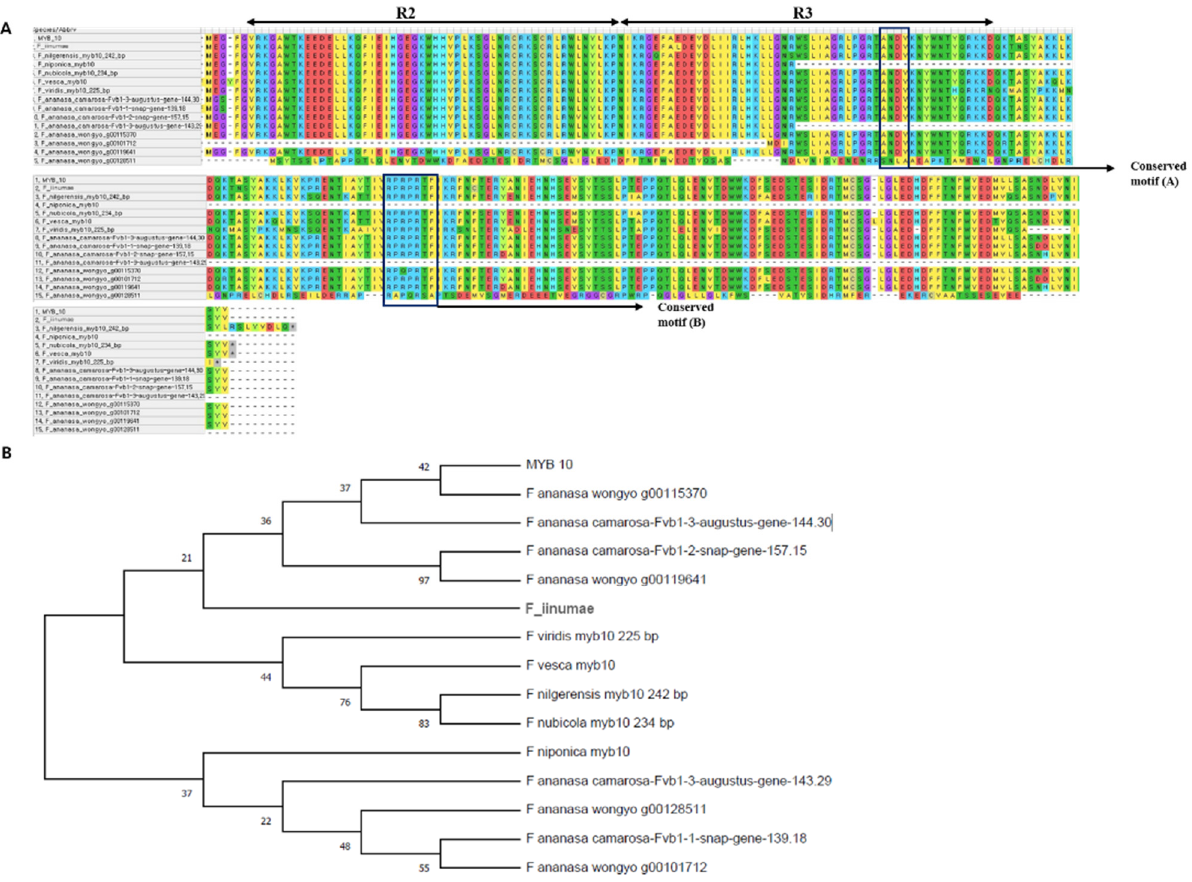
Figure 2. Multiple protein sequence alignment of Fragaria MYB10: ( A ) the conserved motif A [ANDV] and motif B [RPRPRTF] are highlighted; the phylogenetic relationship between MYB10 transcription factors in Fragaria ( B ).